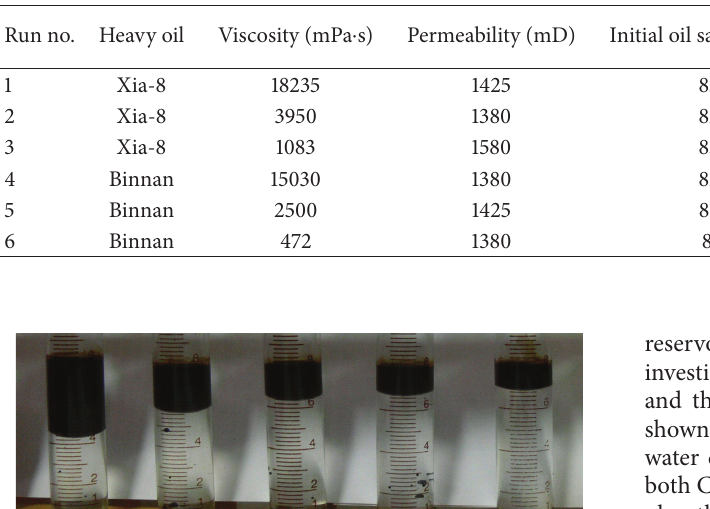
Table 3: Summary of sandpack flooding tests for Xia-8 and Binnan heavy oil.